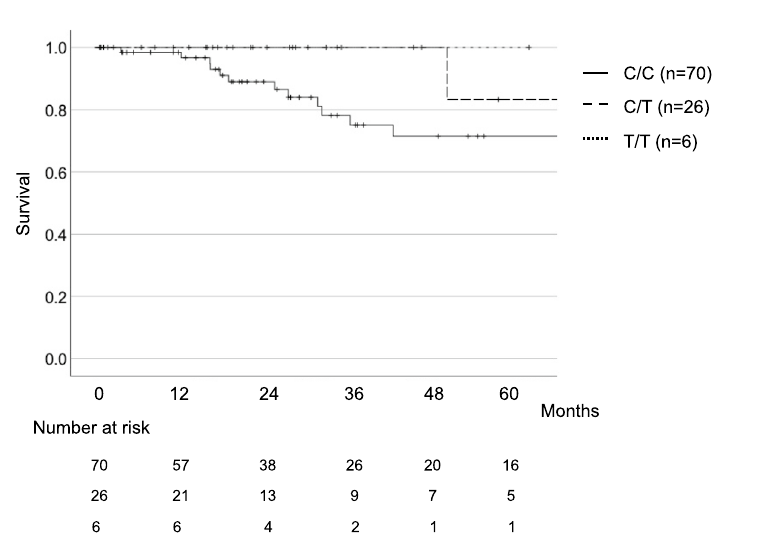
Figure 1. Kaplan–Meier survival curves for each rs3750920 genotype (n =